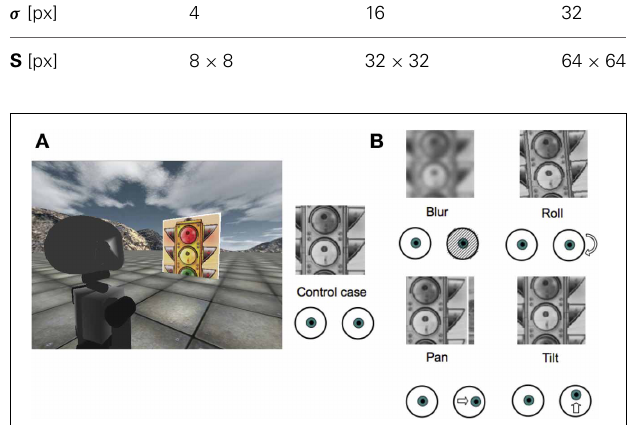
FIGURE 2 | (A) A screenshot from the iCub simulator showing the experimental setup; (B) Types of perturbations applied to right image from the robot camera (Blur of σ = 4 px; Roll of 5 ◦ ; Pan of 4 ◦ ; Tilt of 2 ◦